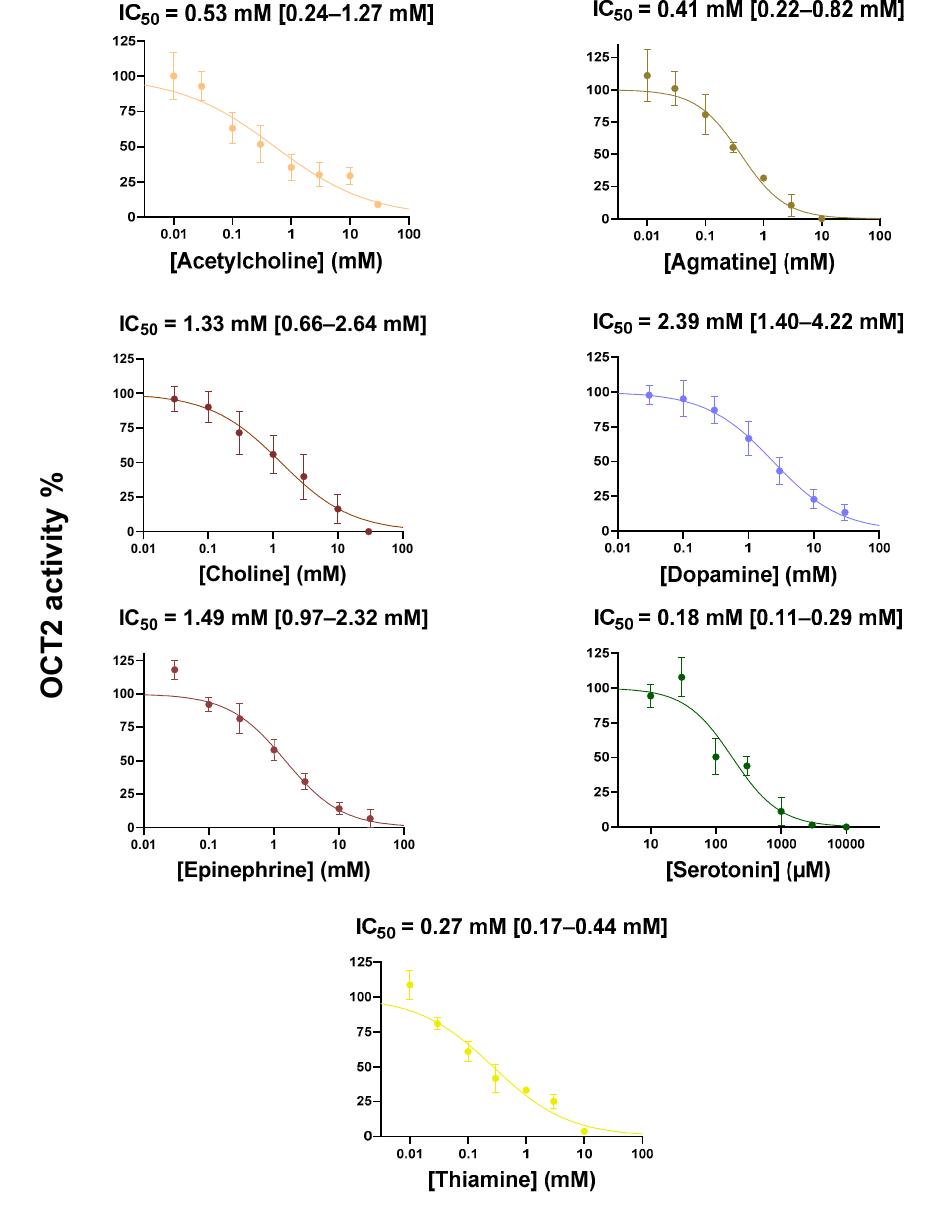
Figure 2. Cis -inhibition of OCT2 activity by endogenous OCT2 substrates. HEK-OCT2 cells were incubated with 10 µM DiASP, used here as a tracer substrate for OCT2, for 5 min at 37 °C, in the absence or presence of various concentrations of endogenous OCT2 substrates. Intracellular accumulation of DiASP was next determined by spectrofluorimetry and normalized to protein content. Data are expressed as % of OCT2 activity found in untreated control cells, arbitrarily set at 100%; they are the means ± SEM of at least three independent experiments performed in quadruplicate. IC 50 values and 95% confidence intervals are indicated on the top of graphs.